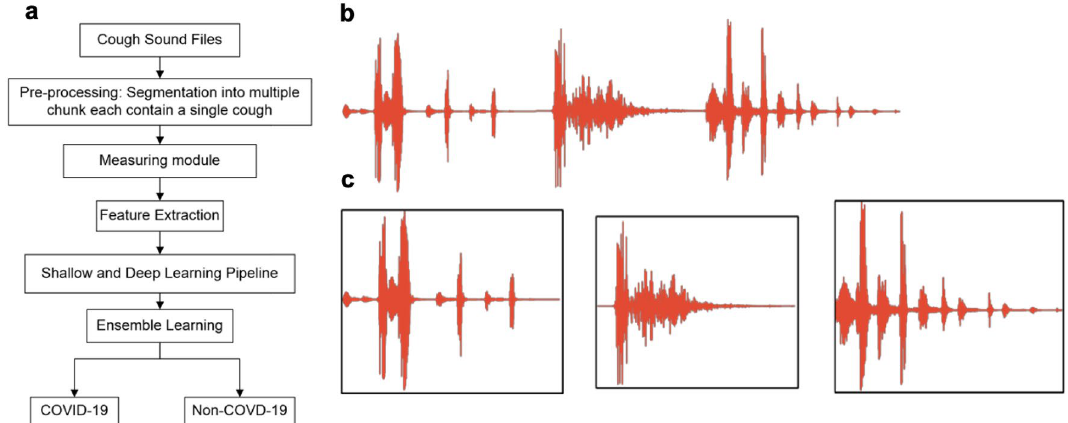
Figure 1. The analytical pipeline for the processing of cough sounds and the sample processed file. ( a ) The analytical pipeline for pre-processing, feature extraction, and ensemble learning from cough sounds; ( b ) Sample original cough recording sound signal; and ( c ) Segmented non-overlapped cough signals.